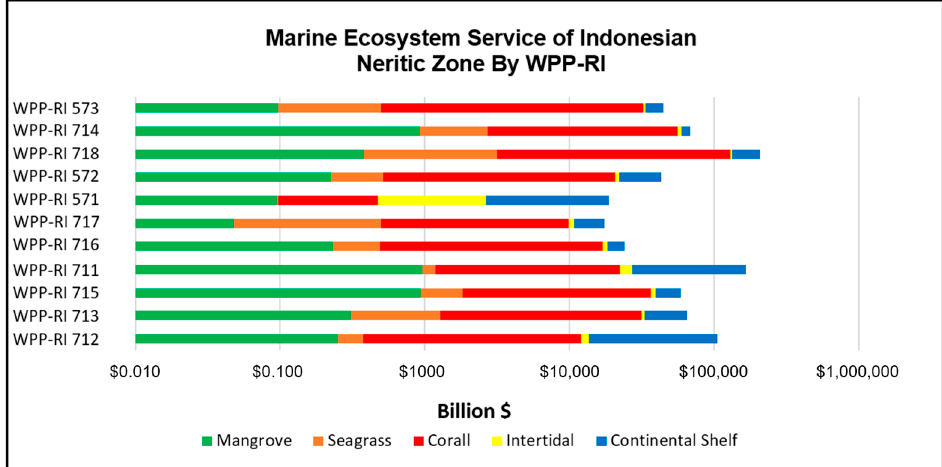
Figure 4. Plot illustrating the marine ecosystem services value in the Indonesian neritic zone by Indonesian Fisheries Management Zone (IFMZ or WPP-RI).